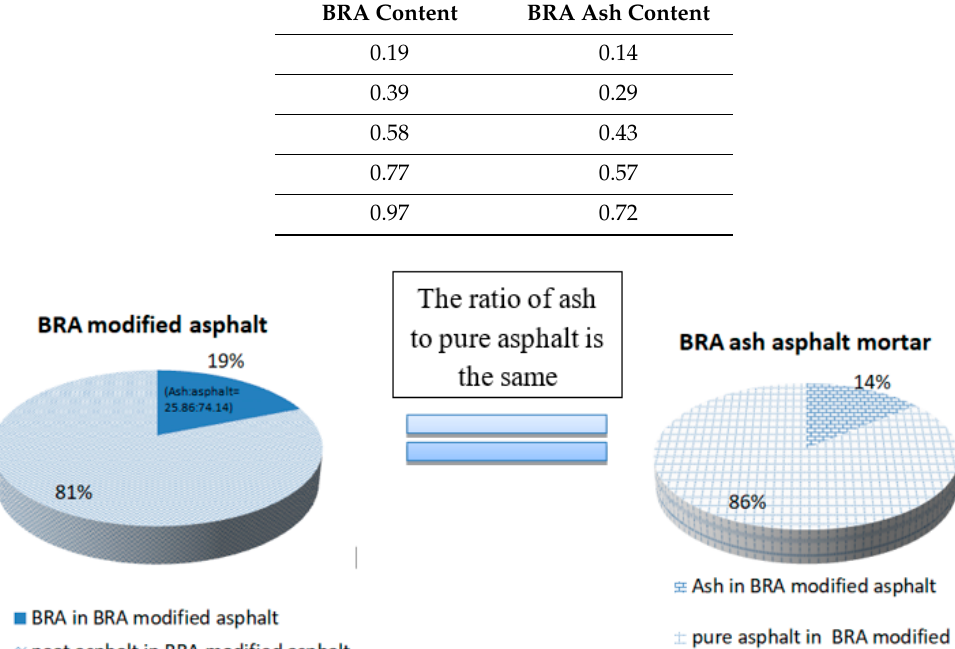
Figure 1. The ratio of ash to pure asphalt is the same.